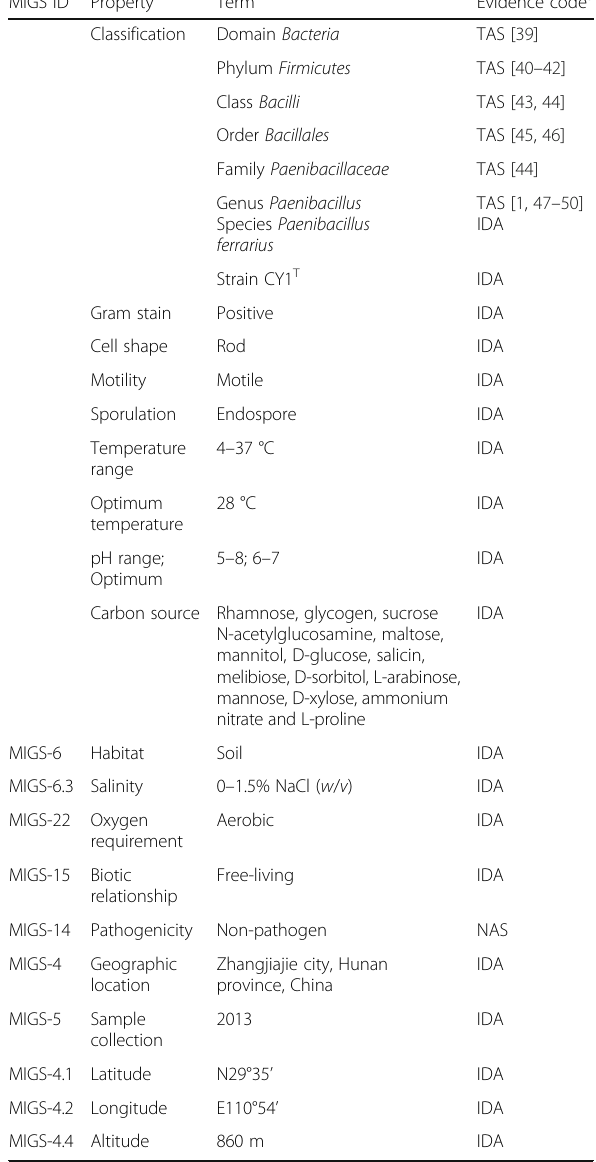
Table 1 Classification and general features of